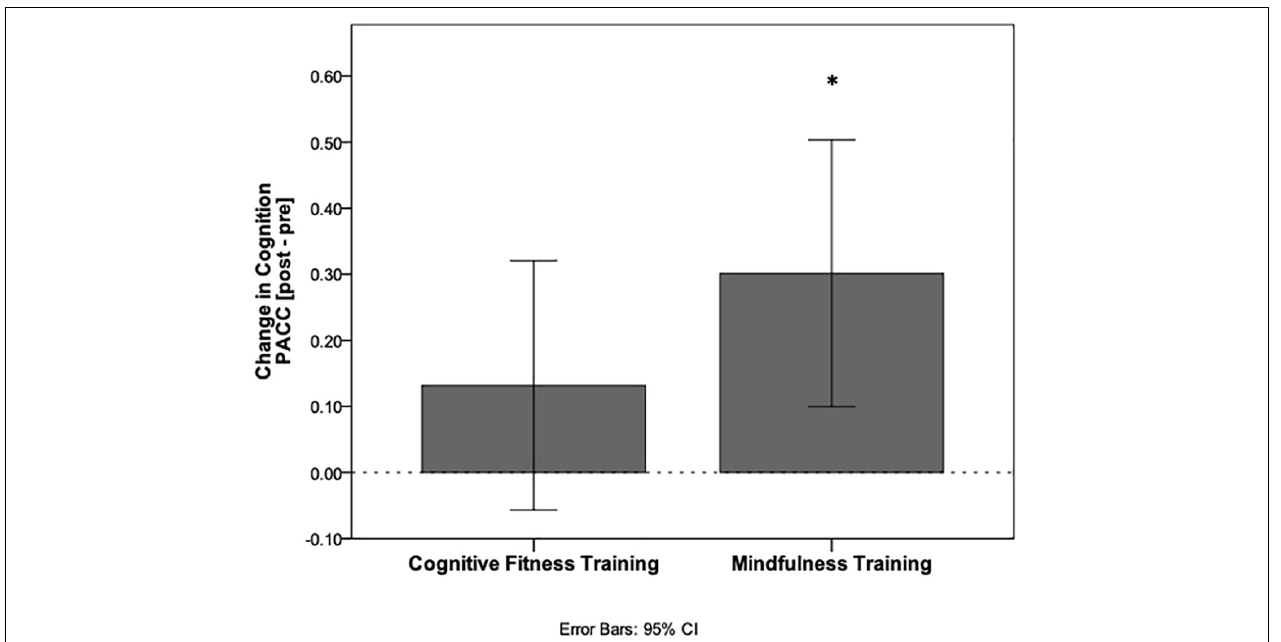
FIGURE 1 | Cognitive improvement relative to baseline performance. PACC scores calculated as change from baseline following the interventions for each group. Mindfulness training resulted in a significant within-group increase in cognition (* p < 0.05), while cognitive fitness training did not.